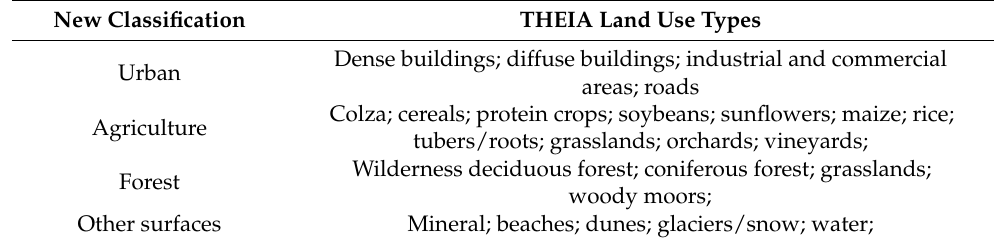
Table 3. New classification of the THEIA land-use data.